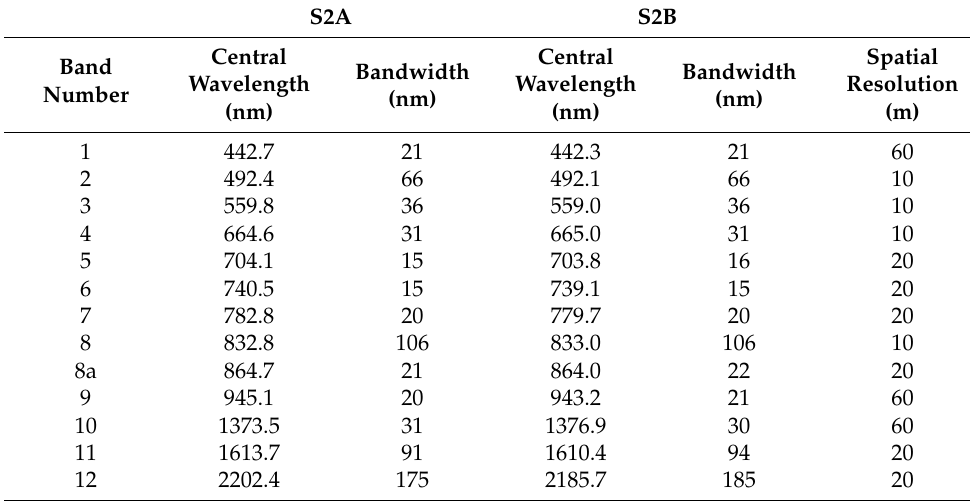
Table 1. Spectral bands of the Sentinel-2 twin satellites’ sensors